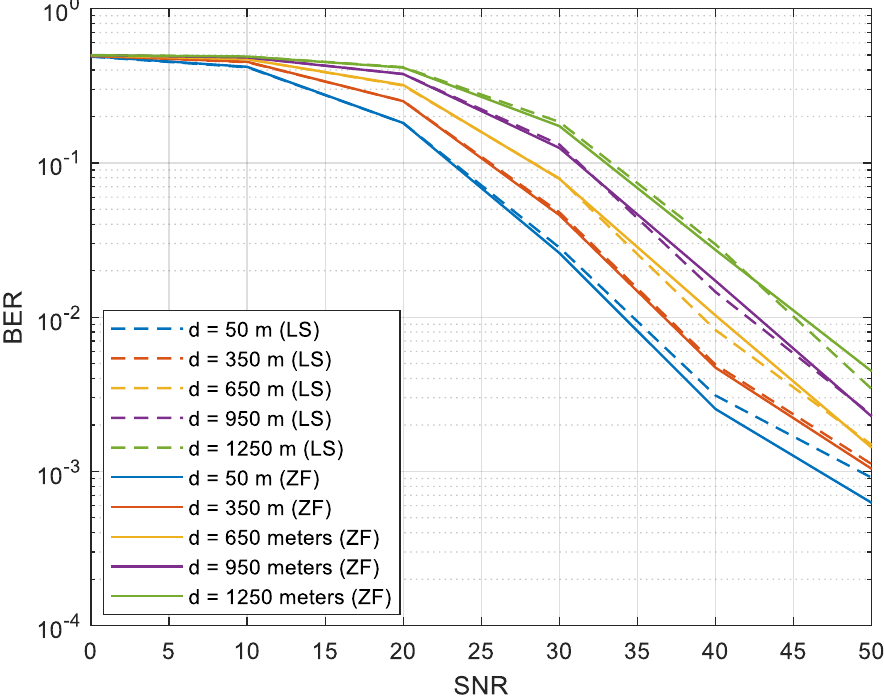
Figure 8. BER of CP-OFDM when using the LS and ZF equalizers as a function of the transmitter- receiver distance with 128 subcarriers and 32 pilots.